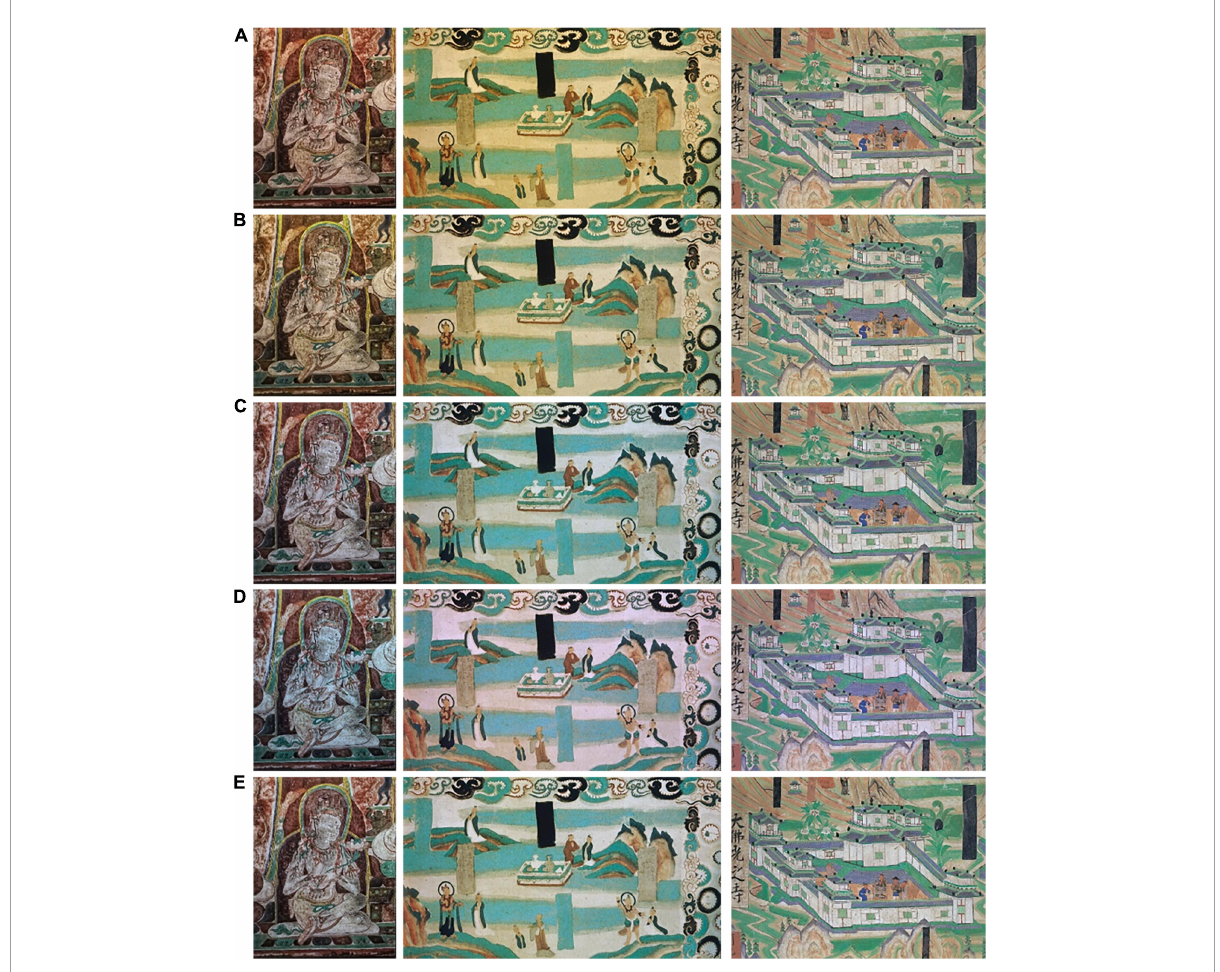
FIGURE13 Comparison of the resulting images. (A) Input image, (B) our method, (C) max-RGB, (D) gray world, (E)